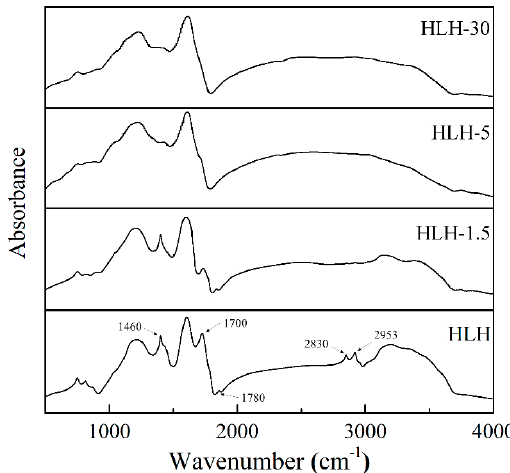
Figure 1. Fourier transform infrared spectroscopy (FTIR) spectra of pretreated samples under di ff erent irradiation times.